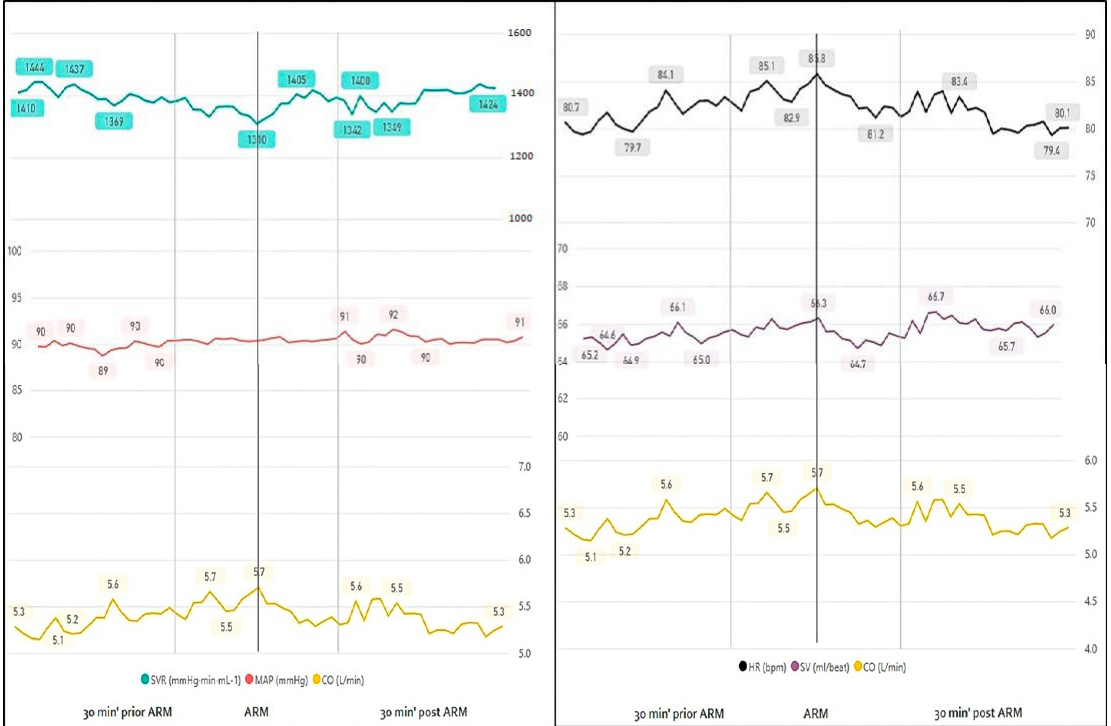
Figure 3. Continuous monitoring 30 min before and after rupture of membranes.